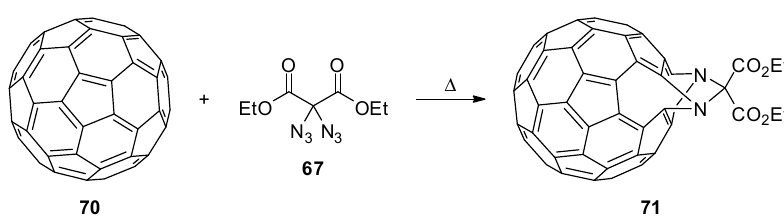
Scheme 14. Functionalisation of C 60 -fullerene ( 70 ) with ethyl 2,2-diazidomalonate ( 67 ).